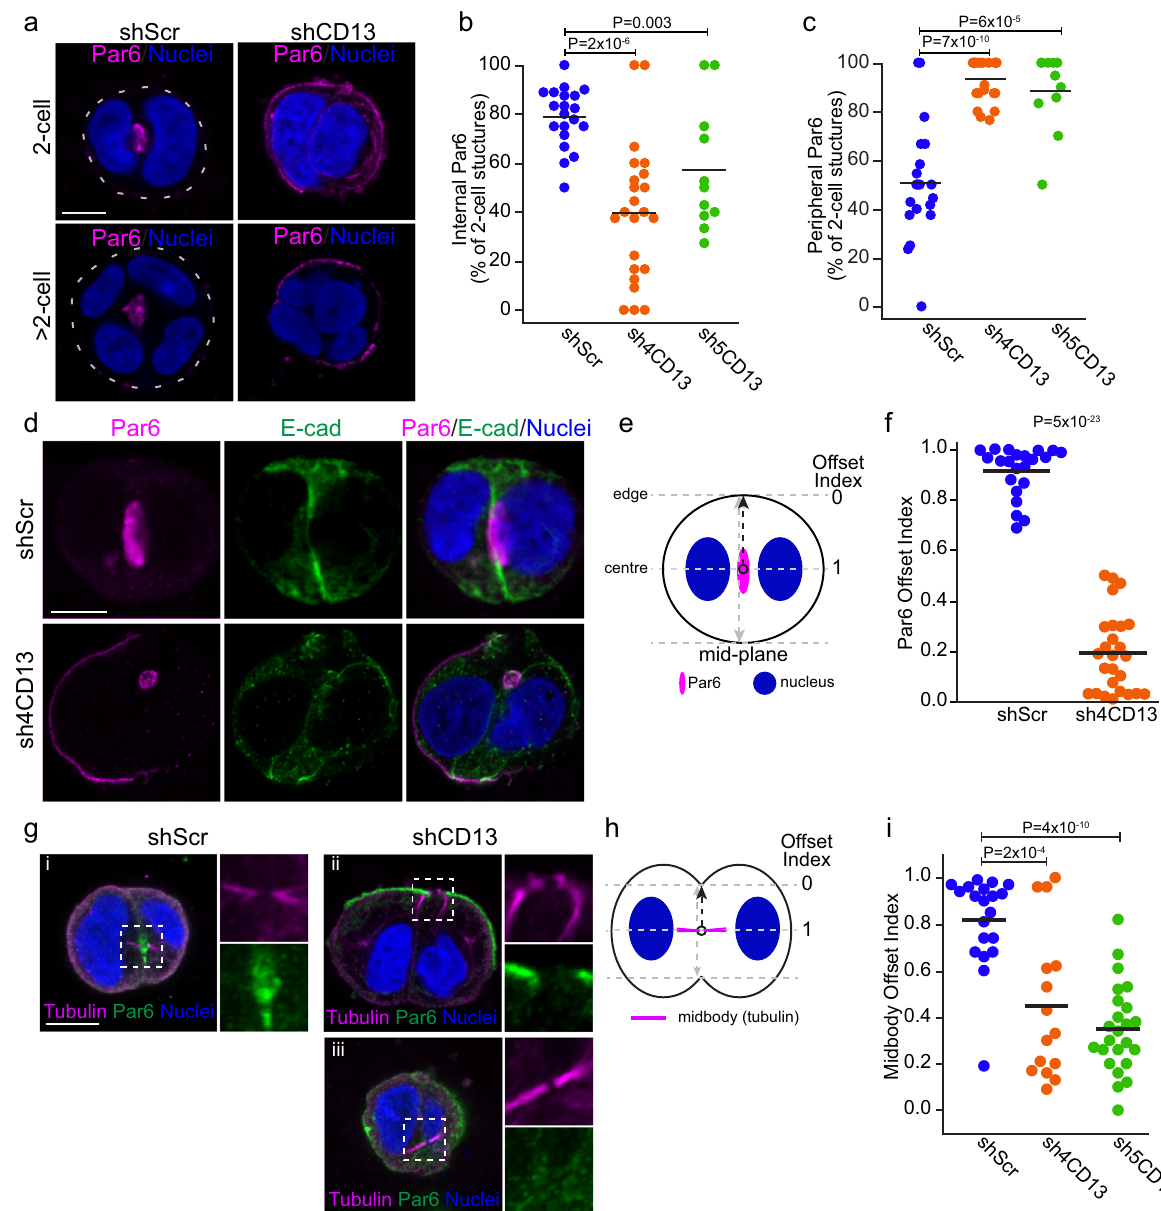
Fig. 4 Depletion of CD13 disrupts midbody position and apical protein accumulation to the midbody. a Confocal images of Par6 (magenta) in control (shScr) and CD13 knock-down 3D Caco-2 structures. b , c Quanti fi cation of the percentage of 3D structures with internal ( b ) and peripheral ( c ) Par6 localization in control shScr ( n = 20), sh4CD13 knock-down ( n = 23) and sh5CD13 knock-down ( n = 13) different fi elds of view. Data are representative of two independent experiments. d Representative confocal images of Par6 (magenta) and E-cad (green) in control and CD13 knock-down 3D Caco-2 structures. e Diagram showing the offset index of Par6 in 2-cell 3D Caco-2 structures. A value of one indicates midbody position at the center of the 3D structure, and values approaching 0 represent midbody positioned closer to the edge. f Quanti fi cation of Par6 offset index from shScr ( n = 22) and sh4- CD13 knock-down ( n = 26) 2-cell 3D Caco-2 structures. Data are representative of three independent experiments. g Confocal images of tubulin (magenta) and Par6 (green) in 2-cell 3D Caco-2 structures. h Diagram showing the offset index of the midbody for the edge and the center (where midbody locates) on 2-cell structure. i Quanti fi cation of midbody offset index from shScr ( n = 20), sh4CD13 knock-down ( n = 15) and sh5CD13 knock- down ( n = 24) on 2-cell 3D Caco-2 structures. Data are representative of three independent experiments. p -values were calculated by ANOVA with Tukey ’ s posthoc test for multiple comparisons ( b , c , i ) or unpaired two-tailed student ’ s t-test ( f ). Images are representative from two ( a ) or three ( d , g ) independent experiments. Bars: a , d , g , 10 μ internal apical membrane patch in control cells, Par6 remained some apical proteins, which fail to internalize from the peripheral on the peripheral plasma membrane in Rab11-knockdown cells plasma membrane. (Fig. 5h). Since both Rab11 and CD13 are required to redistribute To verify that Rab11 is required to redistribute Par6 from the Par6 and other apical proteins to establish an apical membrane peripheral plasma membrane to the internal AMIS, we knocked site and they are in proximity near the cell periphery, we asked down Rab11 from Caco-2 cells and examined Par6 localization at whether they could be physically connected. To test this, we fi rst the 2-cell stage. Whereas Par6 was ef fi ciently translocated to